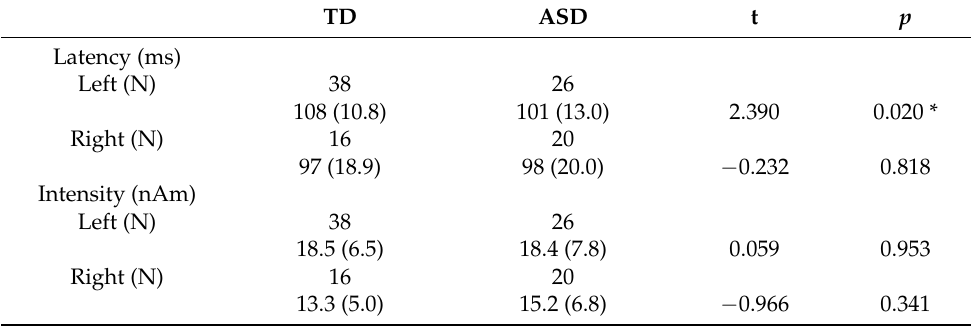
Table 1. P1m component.